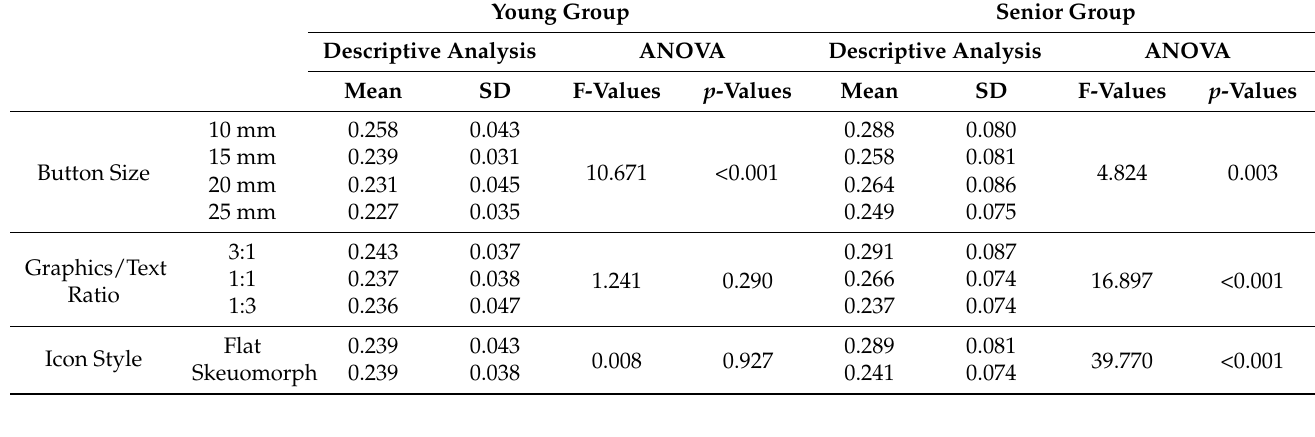
Table 5. Main effects of button size, graphics/text ratio, and icon style on mean fixation time (s).